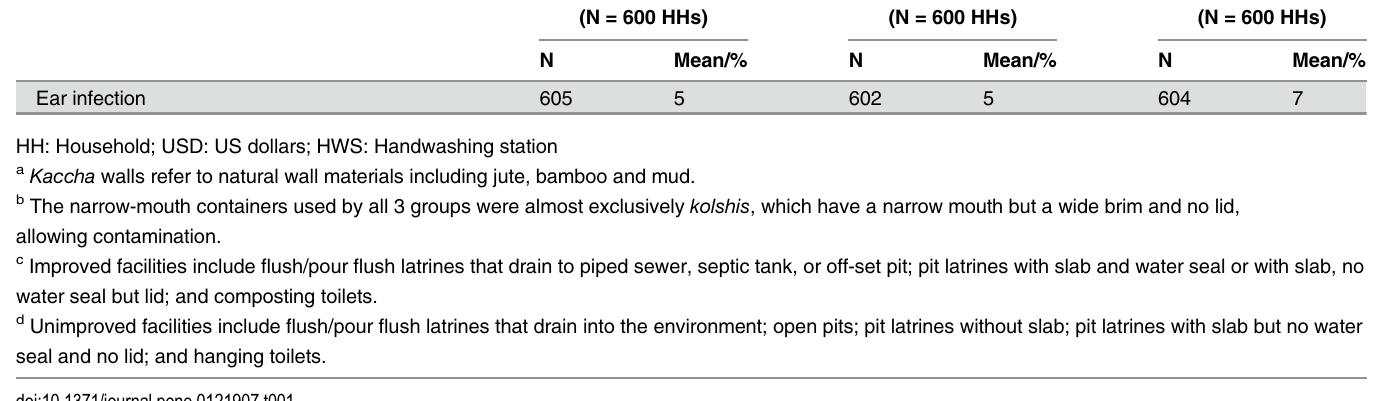
The field team collected 1726 source water samples and 1676 coupled stored water samples over the study period. Among tubewell samples, 41% were positive for E . coli . In 14% of sam- ples, E . coli counts were over the low-risk limit of 10 CFU/100 mL and 3% exceeded the moder- ate-risk limit of 100 CFU/100 mL (Fig. 2); there were no differences in the percentage of samples falling in these risk categories between any pairs of study arms (p > 0.05), indicating similar source water quality across study arms (S6 Table). Contamination of tubewell water was more common during the monsoon season than in the dry season (S4 and S5 Figs, S6 Table), with a higher percentage of samples positive for E . coli ( χ 2 p-value < 0.005) and higher log10 E . coli counts (Wilcoxon rank-sum test p-value < 0.005). Stored water quality showed marked differences between the three arms. In the control arm, 89% of samples were positive for E . coli , suggesting widespread contamination during house- hold storage, compared to 70% in the safe storage arm and 26% in the combined safe storage and chlorination arm (Fig. 3). The percentage of samples with E . coli > 10 CFU/100 mL was 61% in the control arm, 27% in the safe storage arm and 9% in the chlorine arm, and the per- centage of samples with E . coli > 100 CFU/100 mL was 21% in the control arm, 7% in the safe storage arm and 2% in the chlorine arm (Fig. 3). All differences were significant between each pair of study arms (p < 0.05) (S6 Table). The proportion of households that had higher E .